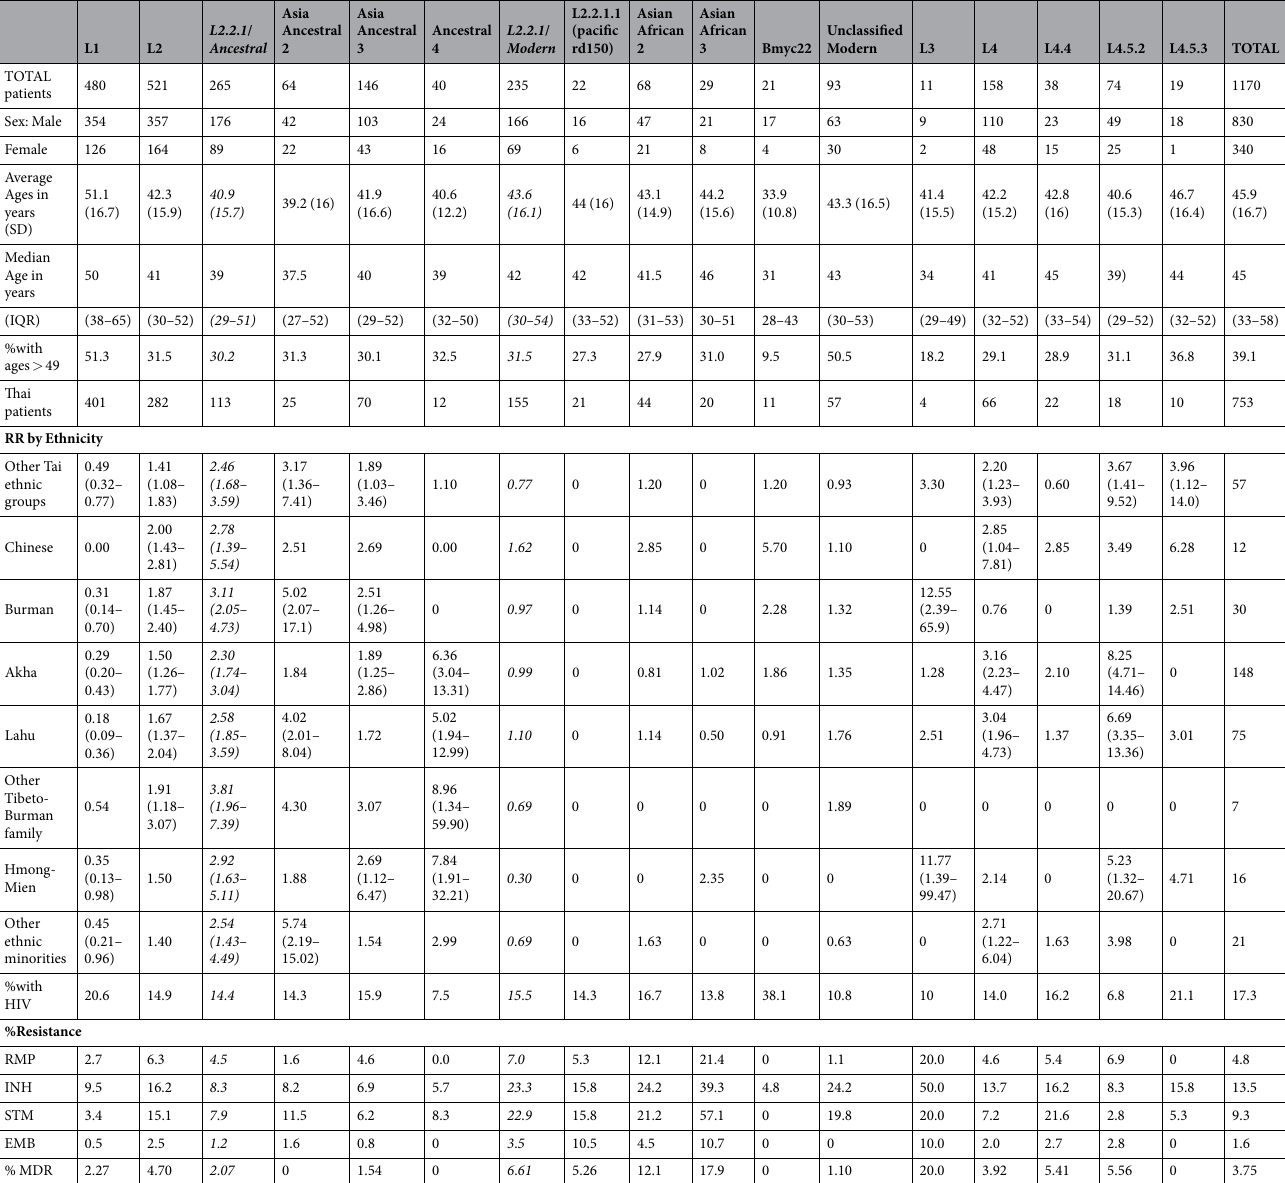
Table 1. The selected demographic and clinical profiles of four lineages and some selected sublineages of L2 and L4. More detailed information is in Supplementary Table S4. SD: standard deviation, IQR: